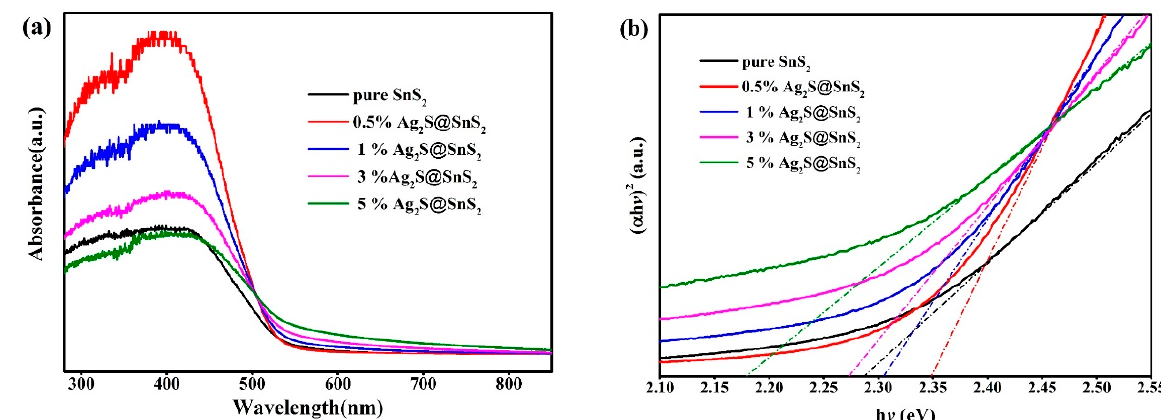
Figure 3. The UV-Vis absorption spectrum ( a ), [ α h υ ] 2 - h υ curve ( b ) of pure SnS2 and Ag 2 S@SnS 2